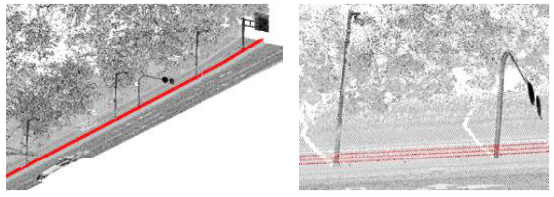
Figure 9. Extracted guardrail